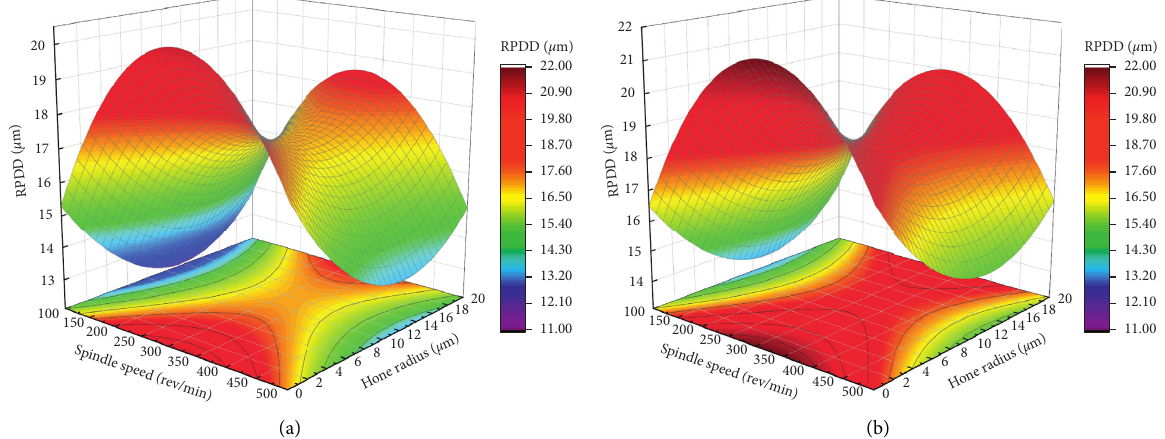
Figure 8: 3D mapping surfaces of RPDD. (a) 2 pitches. (b) 4